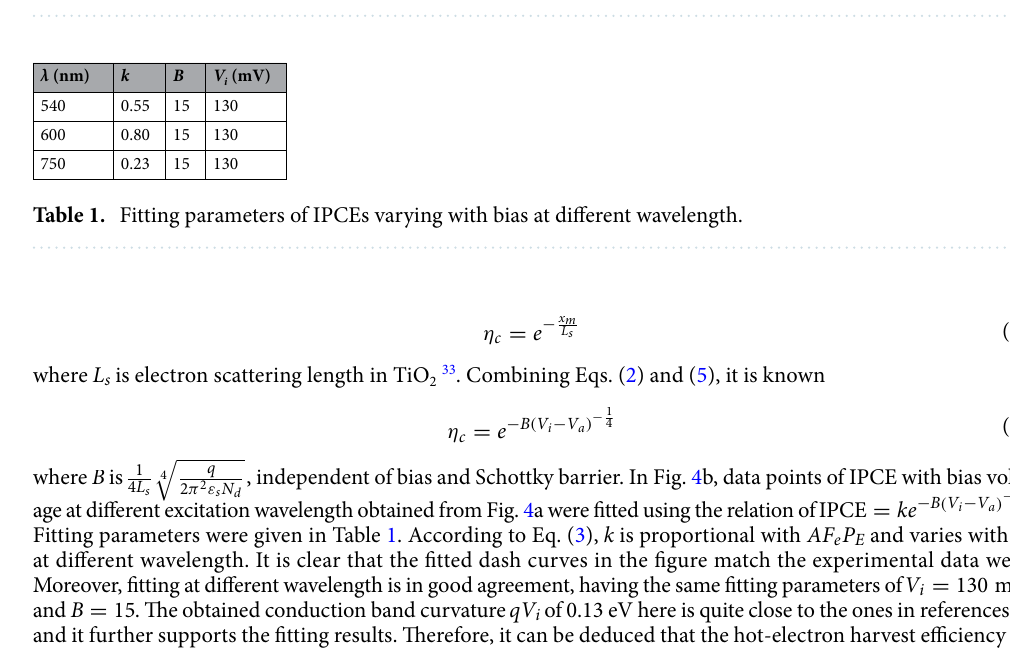
Figure 4. ( a ) IPCE data for AT sample of 80 nm nanodisk diameter at different bias voltages, and ( b ) variation of IPCEs with bias at 540, 600 and 750 nm wavelength from experimental data (hollow marks) and fitting results (dash curves).